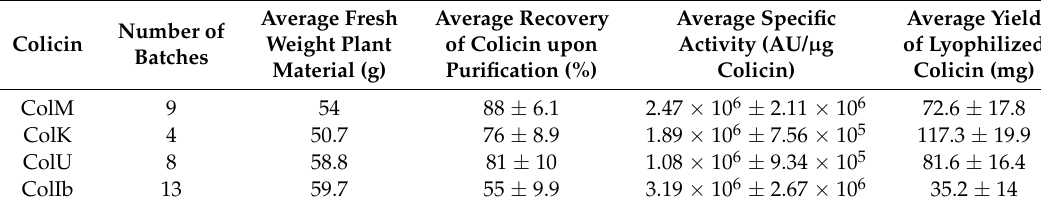
Table 1. Analysis of different batches of purified colicins for the recovery of active antimicrobial proteins. Lyophilized protein samples were inspected for yield of recombinant colicins and yield in specific colicin antimicrobial activity. Antimicrobial activity is expressed in AU (arbitrary units) per microgram ( µ g) recombinant colicin. Average numbers were calculated per batch based on numbers of batches for each colicin as indicated.